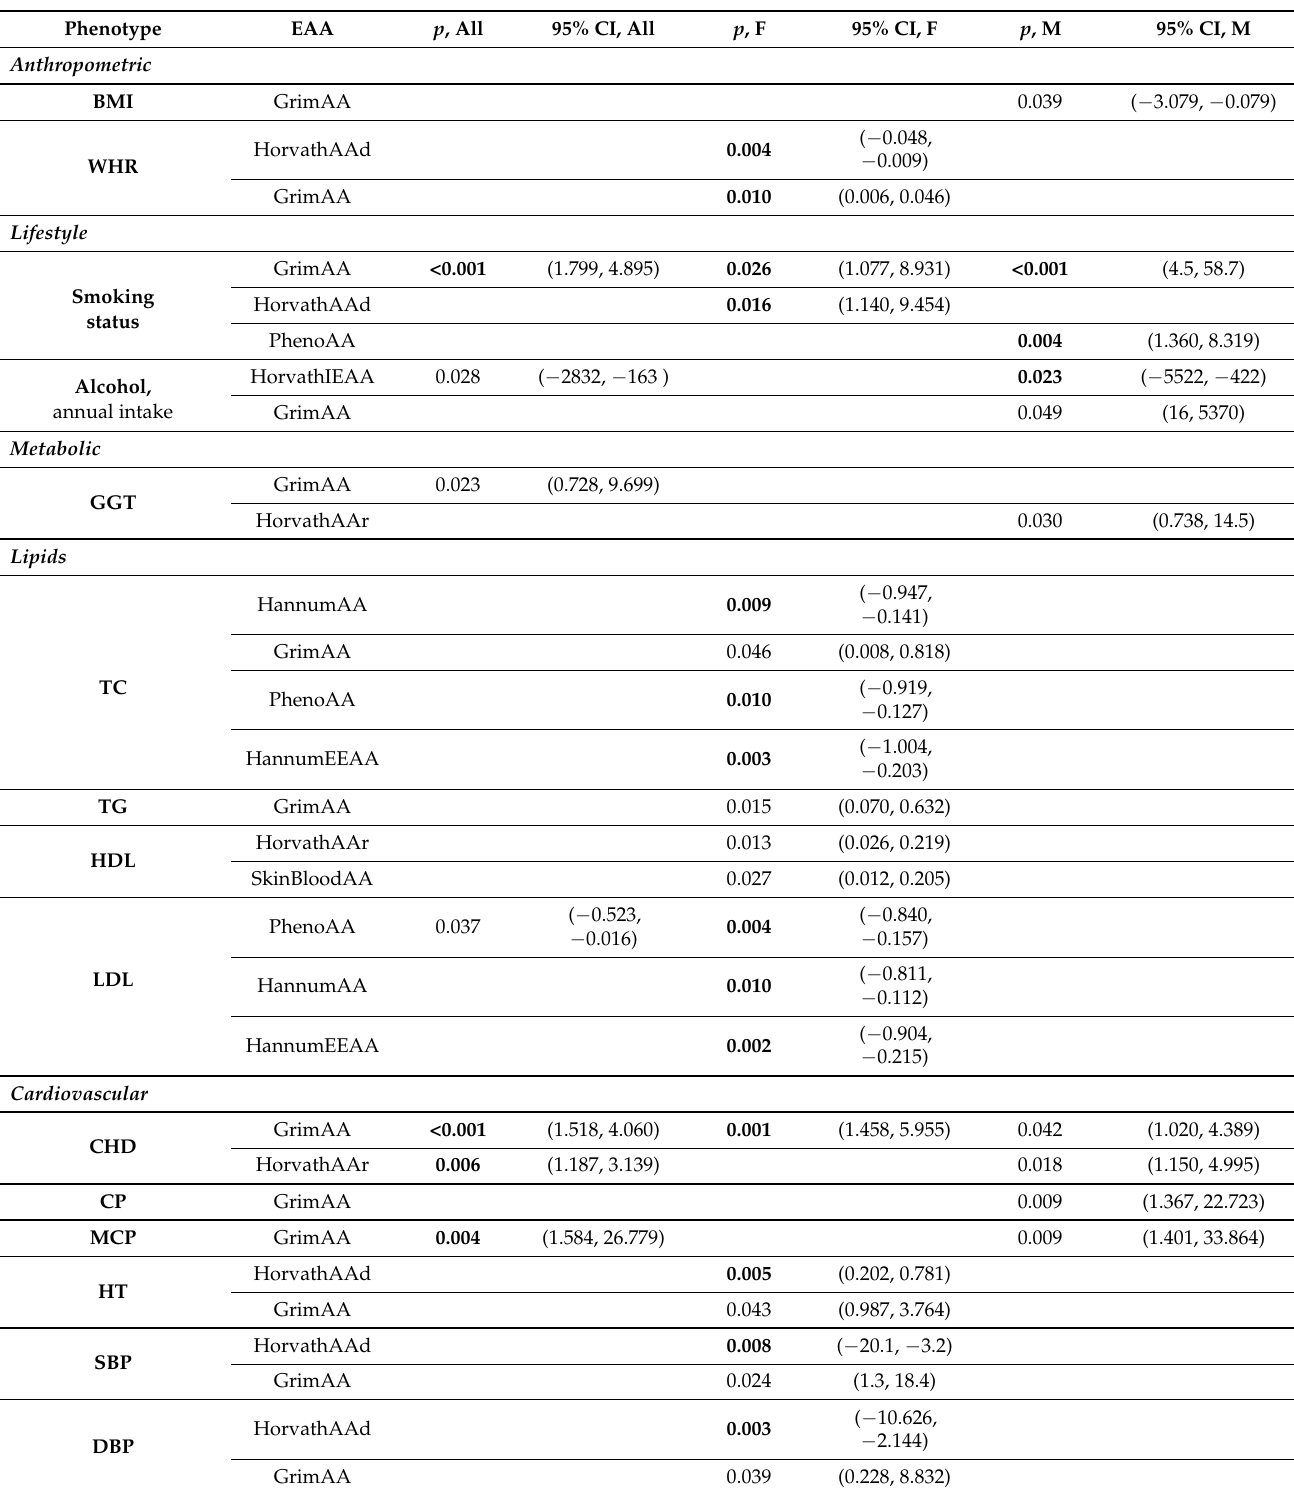
Table 2. Significant differences between groups with positive and negative epigenetic age acceler- ation scores (EAA + and EAA − ). Results which remained significant after controlling for family-wise error rate of 0.05 in groups of phenotypes per clock (as described in the Methods Section 2.6) are presented in bold